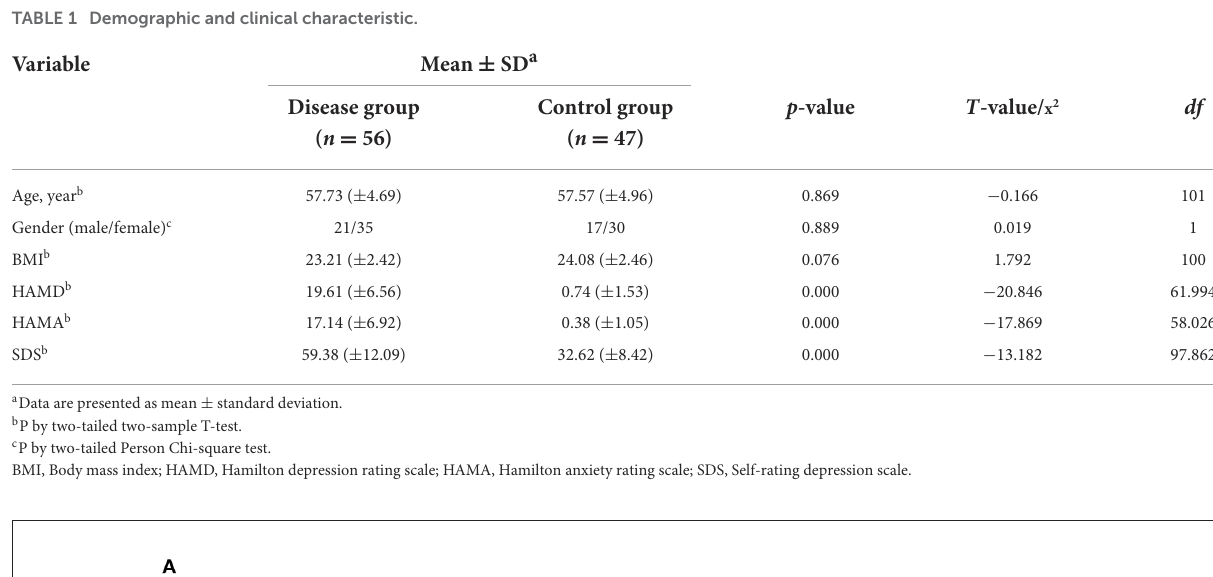
TABLE 1 Demographic and clinical characteristic.